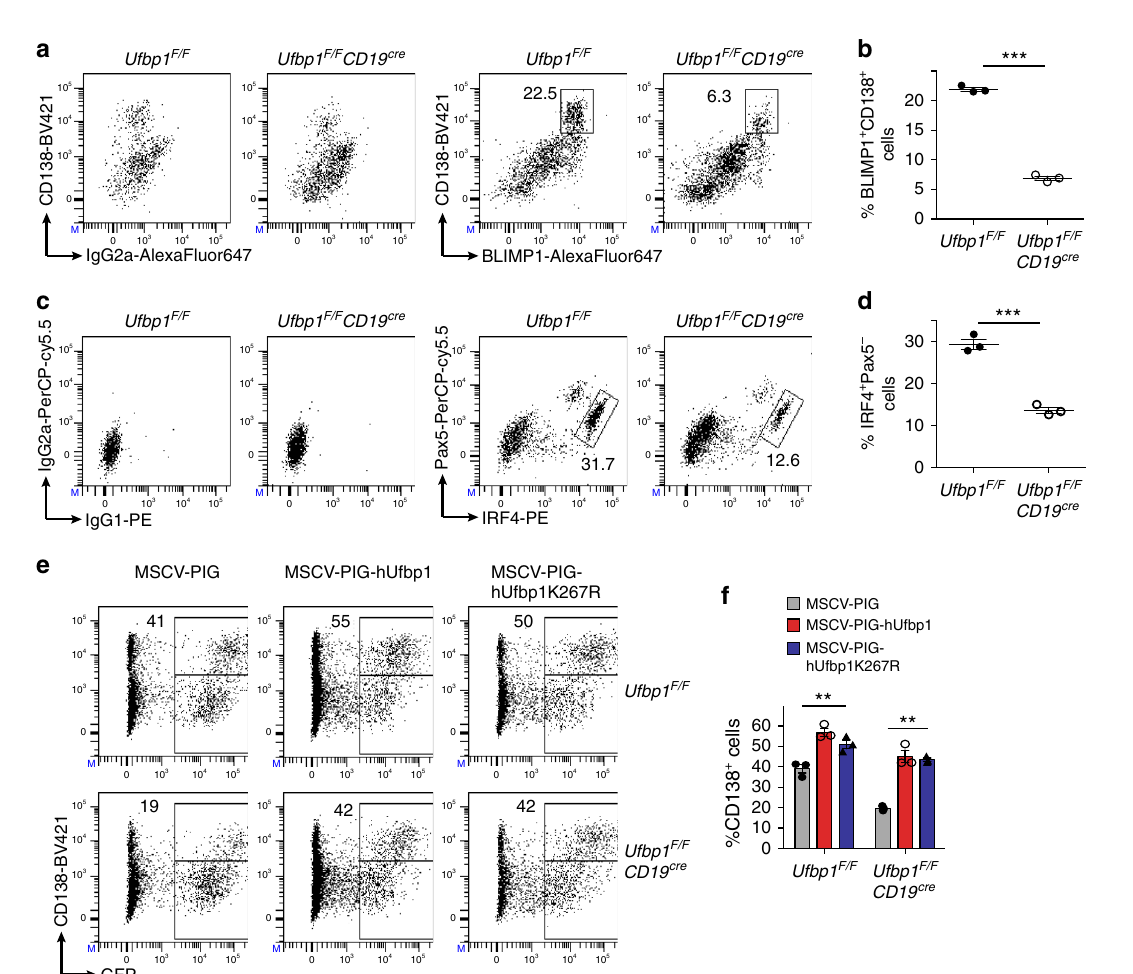
Fig. 3 Defective differentiation of Ufbp1-de fi cient B cells into plasmablasts. a , c Sorted naive B cells from lymph nodes of indicated mice were cultured with lipopolysaccharide (LPS; 1 µ g/ml) + interleukin (IL)-4 (10ng/ml) + IL-5 (5ng/ml). Four days later cells were analyzed for expression of BLIMP1, CD138, IRF4, and Pax5 by fl ow cytometry. Left panels in a and c show control IgG2a, IgG1, and IG2a isotype staining for BLIMP1, IRF4, and Pax5 respectively. Right panels in a and c show staining for BLIMP1 and CD138, and IRF4 and Pax5 respectively. Numbers represent the percent positive cells in the adjacent/ corresponding area. b Enumeration of the frequency of BLIMP1 + CD138 high cells in a ( n = 3 mice/genotype). d Enumeration of the frequency of IRF4 + Pax5 − cells in c ( n = 3 mice/genotype). e Naive B cells from Ufbp1 F/F and Ufbp1 F/F CD19 cre mice were cultured with LPS, IL-4, and IL-5 as above, and transduced with retrovirus containing empty vector (MSCV-PIG), expressing human Ufbp1 (MSCV-PIG-hUfbp1) or Ufbp1K267R (MSCV-PIG-hUfbp1K267R). Transduction of cells with retroviruses was monitored by expression of green fuorescent protein (GFP). Two days after transduction, cells were analyzed for GFP and CD138. Numbers represent percent CD138 + cells within GFP + cells. f Enumeration of the frequency of CD138 + cells among GFP + cells in e ( n = 3 mice/genotype). Error bars represent mean ±standard error. ** P < 0.01, *** P < 0.001. Unpaired Student ’ s two-tailed t -test was used. A representative of at least two experiments is shown